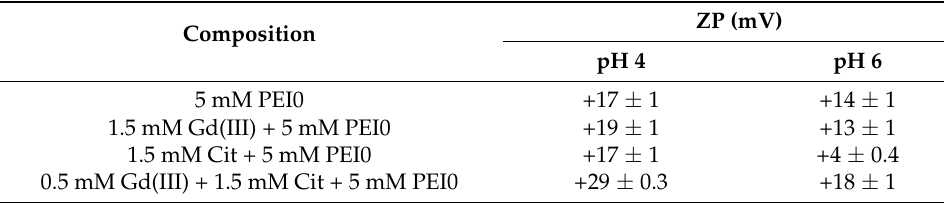
Table 4. Zeta potential (ZP) of investigated Gd(III)–Citrate–PEI0 compositions.